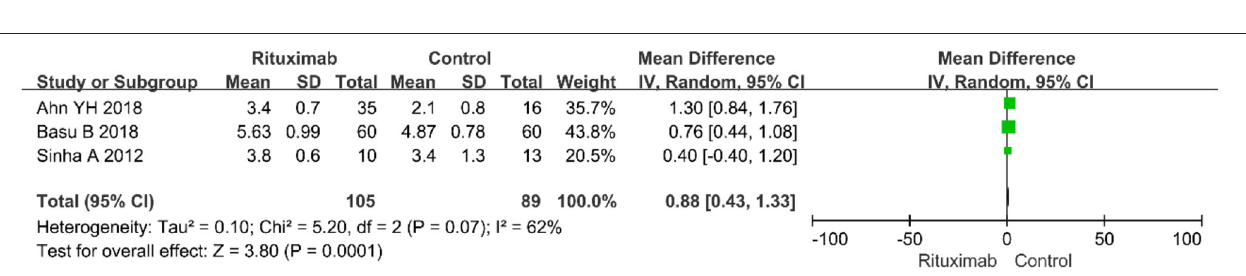
FIGURE 3 | Forest plot showing a meta-analysis of complete remission rate between rituximab treatment group and control group.